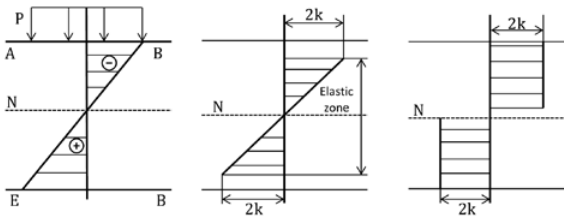
Fig. 6. Stress distribution diagrams in the elastic